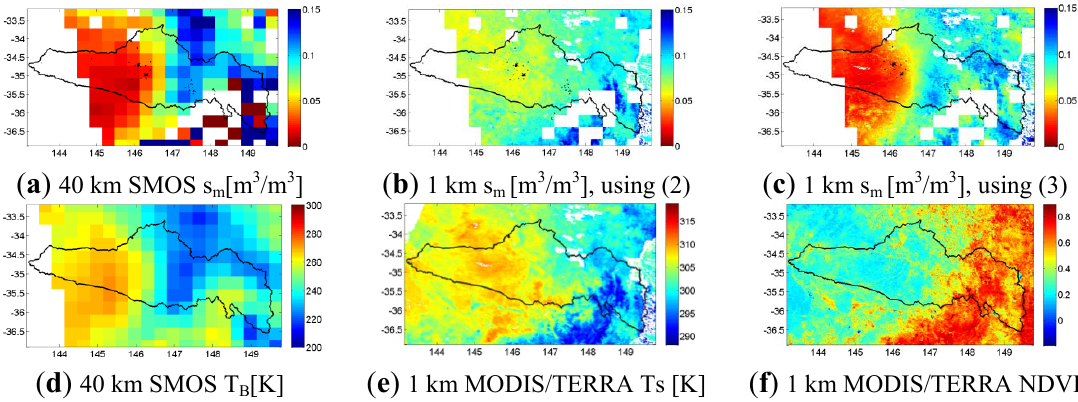
Figure 16. Sample results with SMOS data over the Murrumbidgee catchment, from 17 February 2010 (6 am). ( a ) SMOS soil moisture [m 3 /m 3 ] on a 40 × 40 grid; ( b ) 1 km SMOS- derived soil moisture maps [m 3 /m 3 ] using the linking model in (2); ( c ) 1 km SMOS-derived soil moisture maps [m 3 /m 3 ] using the linking model in (3); ( d ) SMOS T image [K] at Bh 42.5° on a 40 × 40 km grid; ( e ) 1 km MODIS/TERRA Ts [K]; ( f ) 1 km MODIS/TERRA NDVI. Empty areas in the image correspond to unsuccessful SMOS soil moisture retrievals, or clouds masking MODIS T s